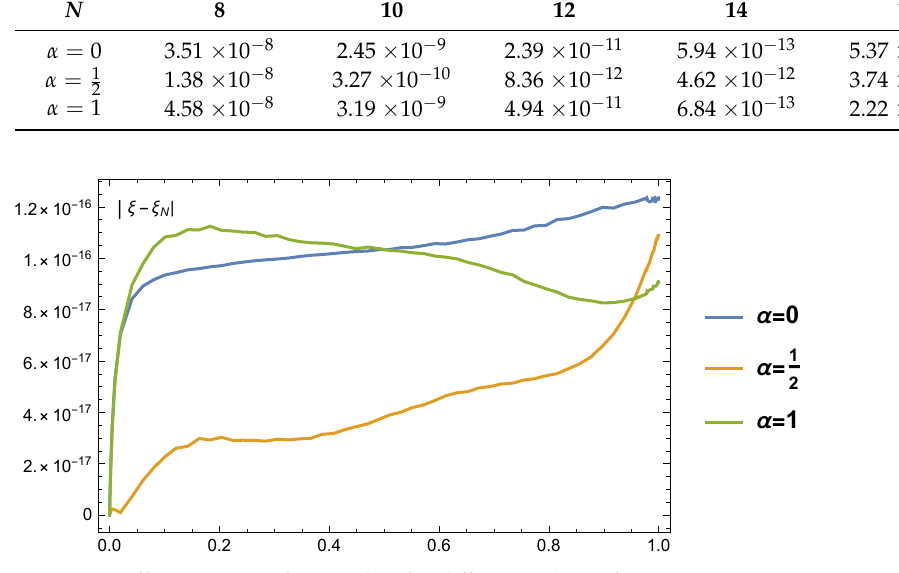
Figure 2. Different errors of Example 2 for different values of α